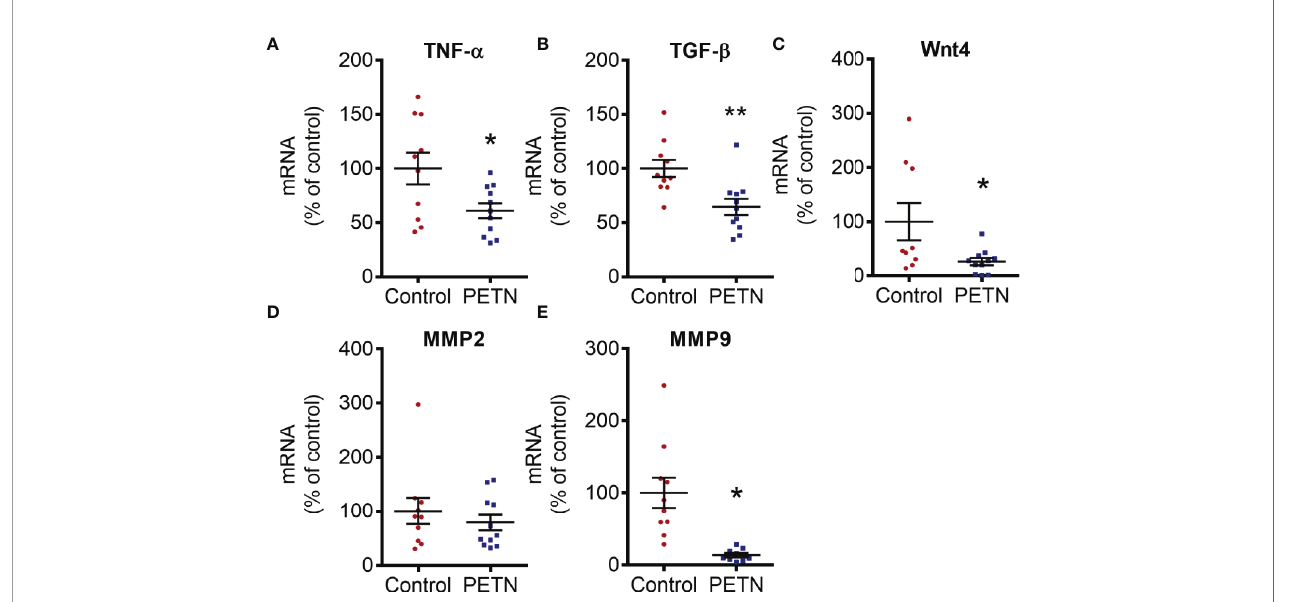
FIGURE 5 | Maternal pentaerythritol tetranitrate (PETN) treatment downregulates pro fi brotic signaling pathways in the female offspring. Parental spontaneously hypertensive rats (SHR) were treated with or without PETN (50 mg/kg/day) during pregnancy and lactation periods. The mRNA expression of tumor necrosis factor (TNF- a ) (A) , Wnt4 (B) , transforming growth factor beta (TGF- b ) (C) and matrix metalloproteinase (MMP2 and MMP9) (D , E) in the kidney of 16-week-old offspring were studied with quantitative real-time PCR. RNA polymerase II was used as reference gene for qPCR. Column represents mean ± SEM, n=10 – 11. Student ’ s t test was used for comparison of PETN group with control group. * P < 0.05, ** P < 0.01; vs. control group.